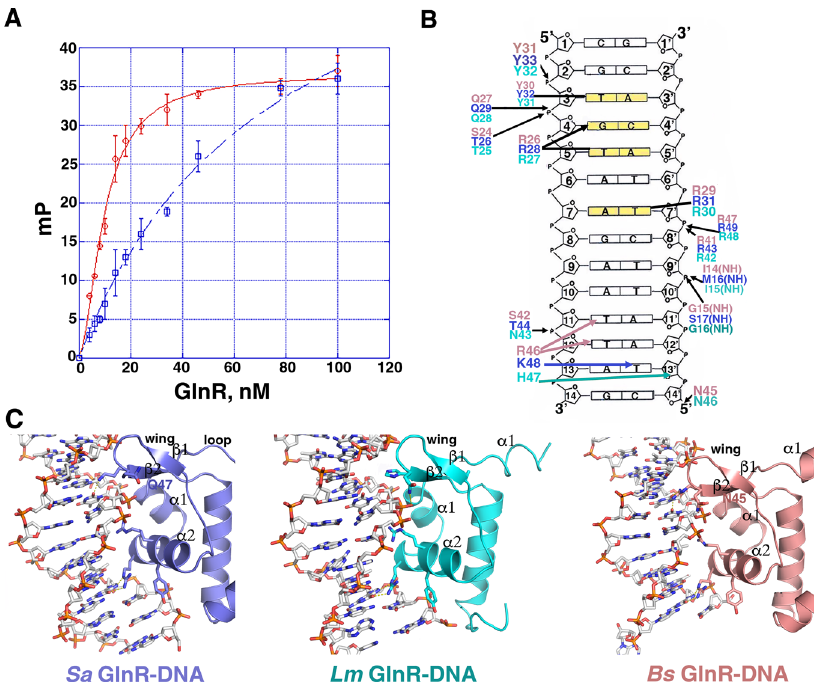
Fig. 8 GlnR-DNA contacts. A FP based assays analyzing binding to the 21 bp operator by FL and truncated Sa GlnR, which resulted in K d s of 9.9 ± 0.9 nM and 75 ± 8.0 nM, respectively. The curves are representative curves from three technical repeats. The error bars represent SD. Data were presented as mean values ± SD. Source data are provided in the Source Data fi le. B Schematic representation of Sa, Bs , and Lm GlnR contacts to DNA. Residues that contact the DNA from Sa, Bs , and Lm GlnR are indicated in salmon, cyan, and slate, respectively. C Close-up view of the DNA contacts from each GlnR subunit to a half-site (contacts by the other subunit to the other half-site are identical).